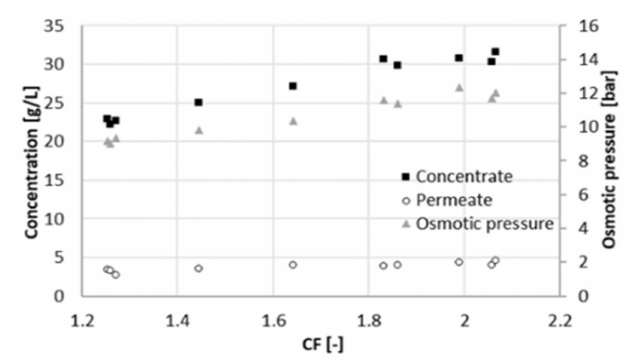
Figure 6. Osmotic pressure and acetate concentrations in the concentrate and in the permeate at different concentration factors CF (25 bar).